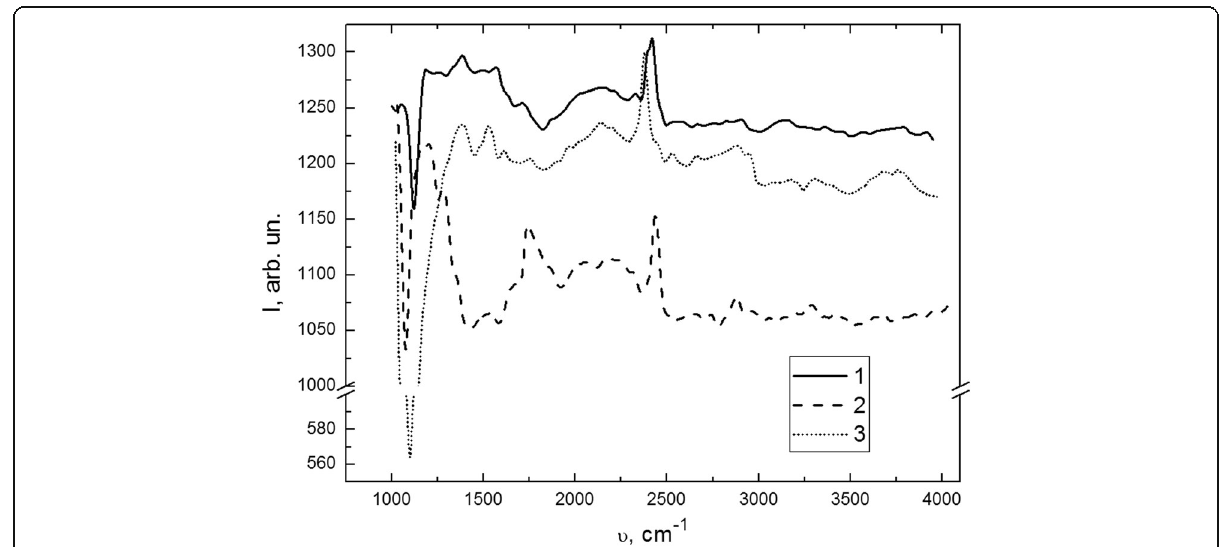
Fig. 4 IR spectra of atoms and molecules vibrational levels in p-type silicon crystals subjected to a different type of pretreatment: 1 initial sample of p-type silicon, 2 plastically deformed sample with the concentration of dislocations N d ≈ 10 7 cm − 2 , 3 plastically deformed sample